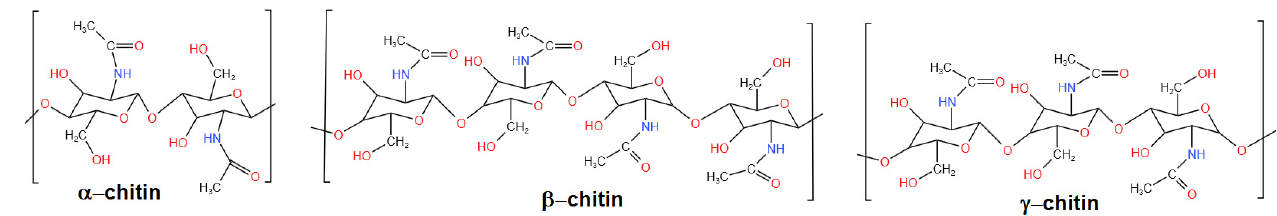
Figure 1. Allomorph form of chitin.